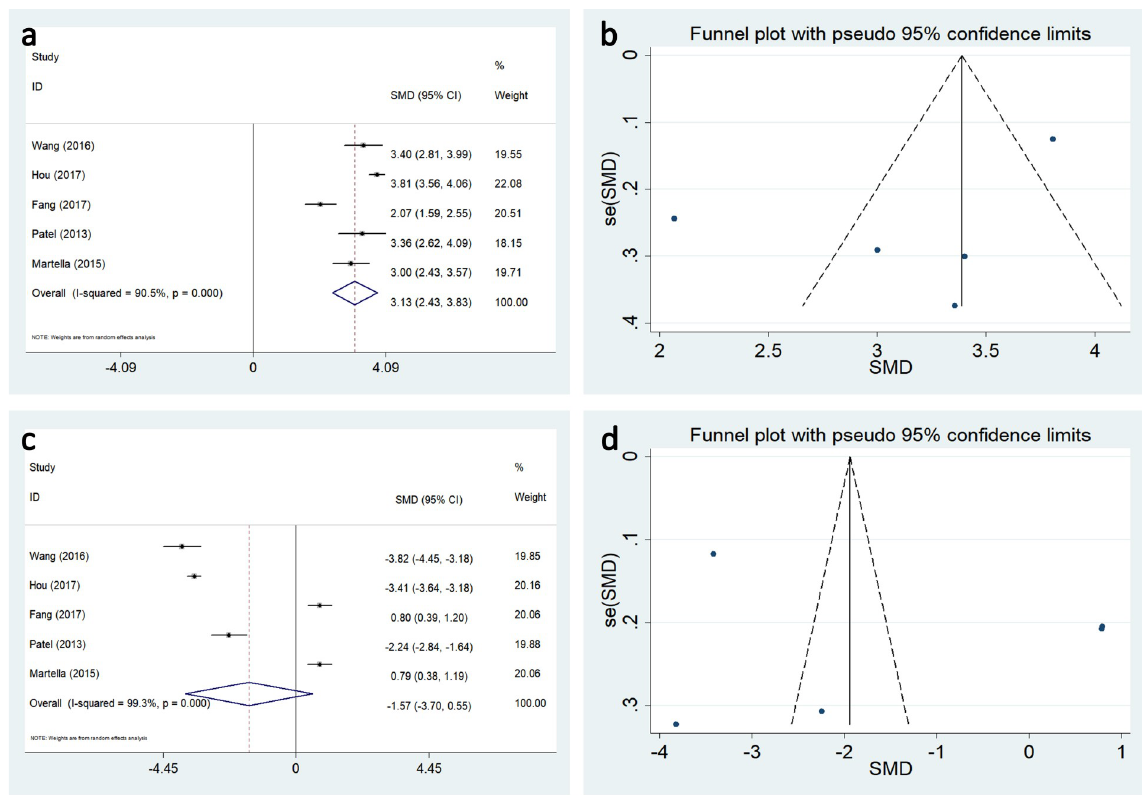
Fig 6. Forest plots and funnel plots for publication bias test for the comparing data related to cost between TIVAP and PICC. (a and b) the catheters maintain less than 6 months, (c and d) the catheter duration more than 12 months.